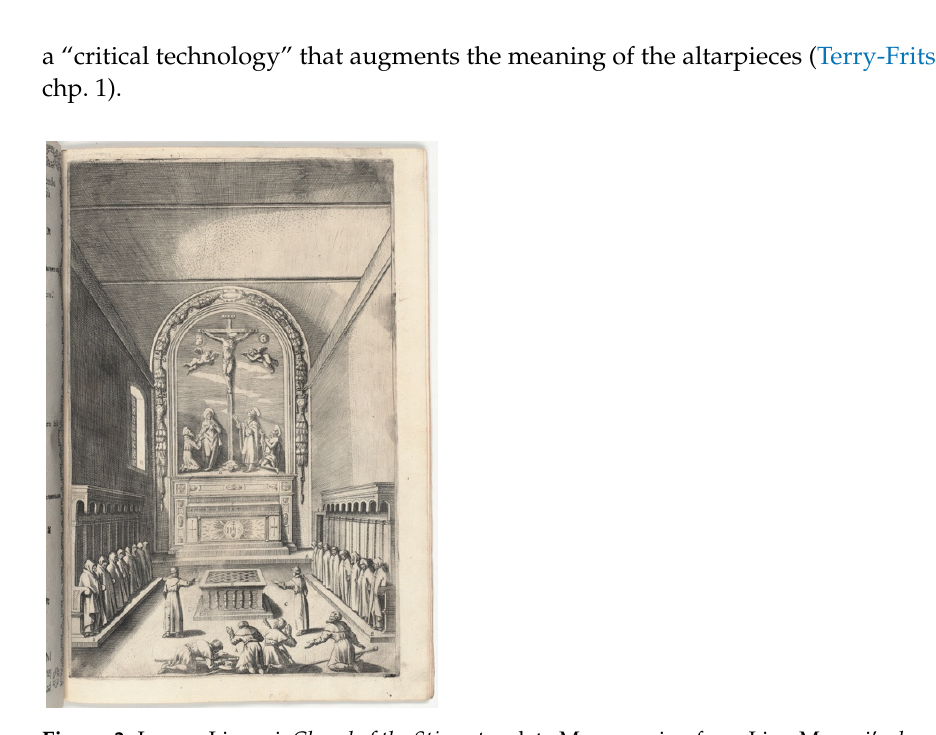
Figure 3. Jacopo Ligozzi, Chapel of the Stigmata , plate M, engraving from Lino Moroni’s descrizione del Sacro Monte della Vernia , 1612 (photo source: Courtesy National Gallery of Art, Washington).